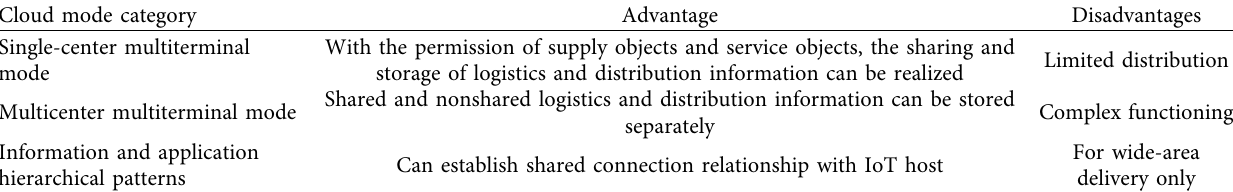
Table 1: List of IoT cloud models.